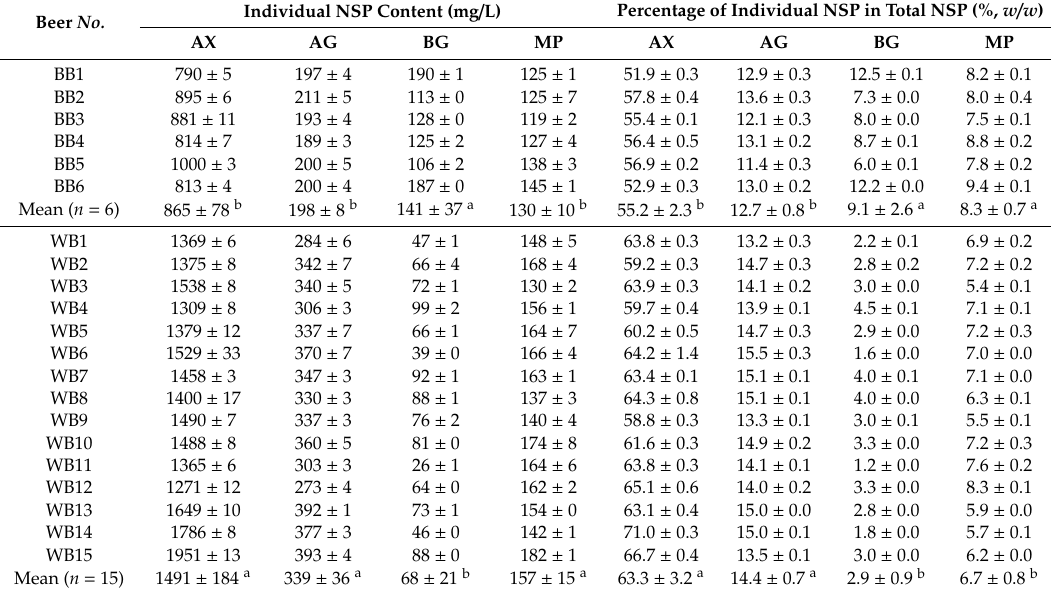
Table 3. Content and percentage of arabinoxylan, arabinogalactan, β -glucan, and mannose polymers in total non-starch polysaccharides. Beer